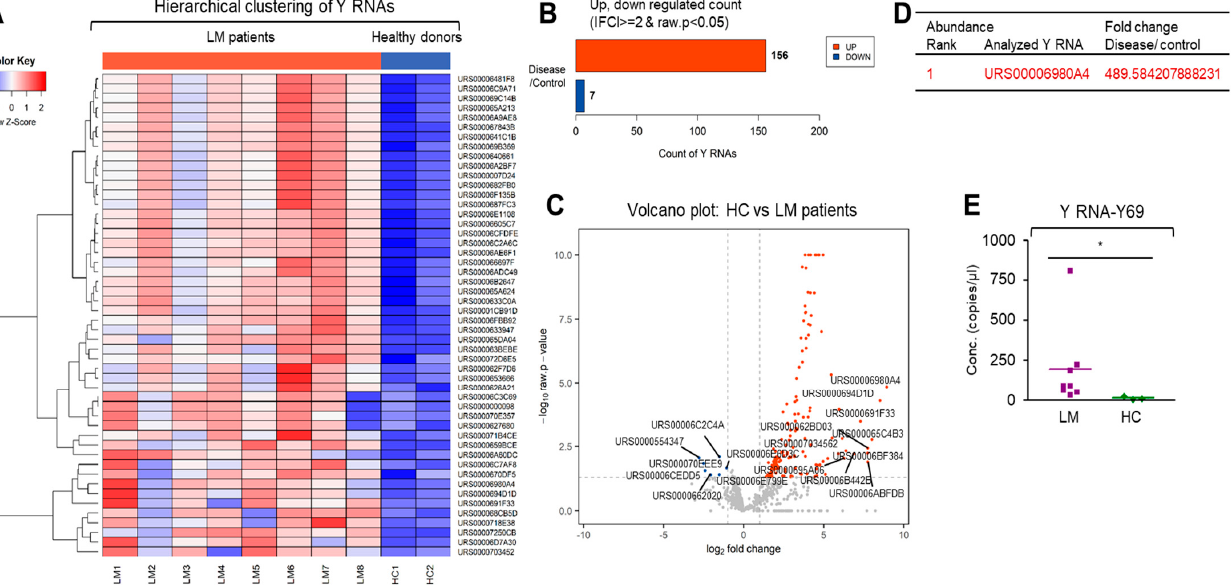
Figure 8. Distinct expression of Y RNAs in EVs from LM patient CSF. Analysis of relative Y RNA expression profile in EVs extracted from LMs and HCs. Hierarchical clustering analysis of significantly expressed Y RNA was visualized via ( A ) heatmap showing z score of extravesicular Y RNA from HC ( n = 2) and patients with LM ( n = 8) with 50 Y RNA that best satisfied FC2 value and adjusted p -value. ( B ) Count of up- and downregulated Y RNA was found by fold change and raw p -value. ( C ) Volcano plot shows differentially expressed Y RNA in HC and LM patients with the x-axis showing log2 fold-change and y-axis showing -log10 of the raw p -value from LM versus HC Y RNA expression counts. ( D ) Table displays the fold change of a Y RNA in LM compared to HC ranked in the order of abundance. ( E ) The upregulated Y RNA-Y69 expression was confirmed in HC ( n = 3) and LM EVs ( n = 8) using ddPCR (Mann-Whitney U test, * p < 0.05).